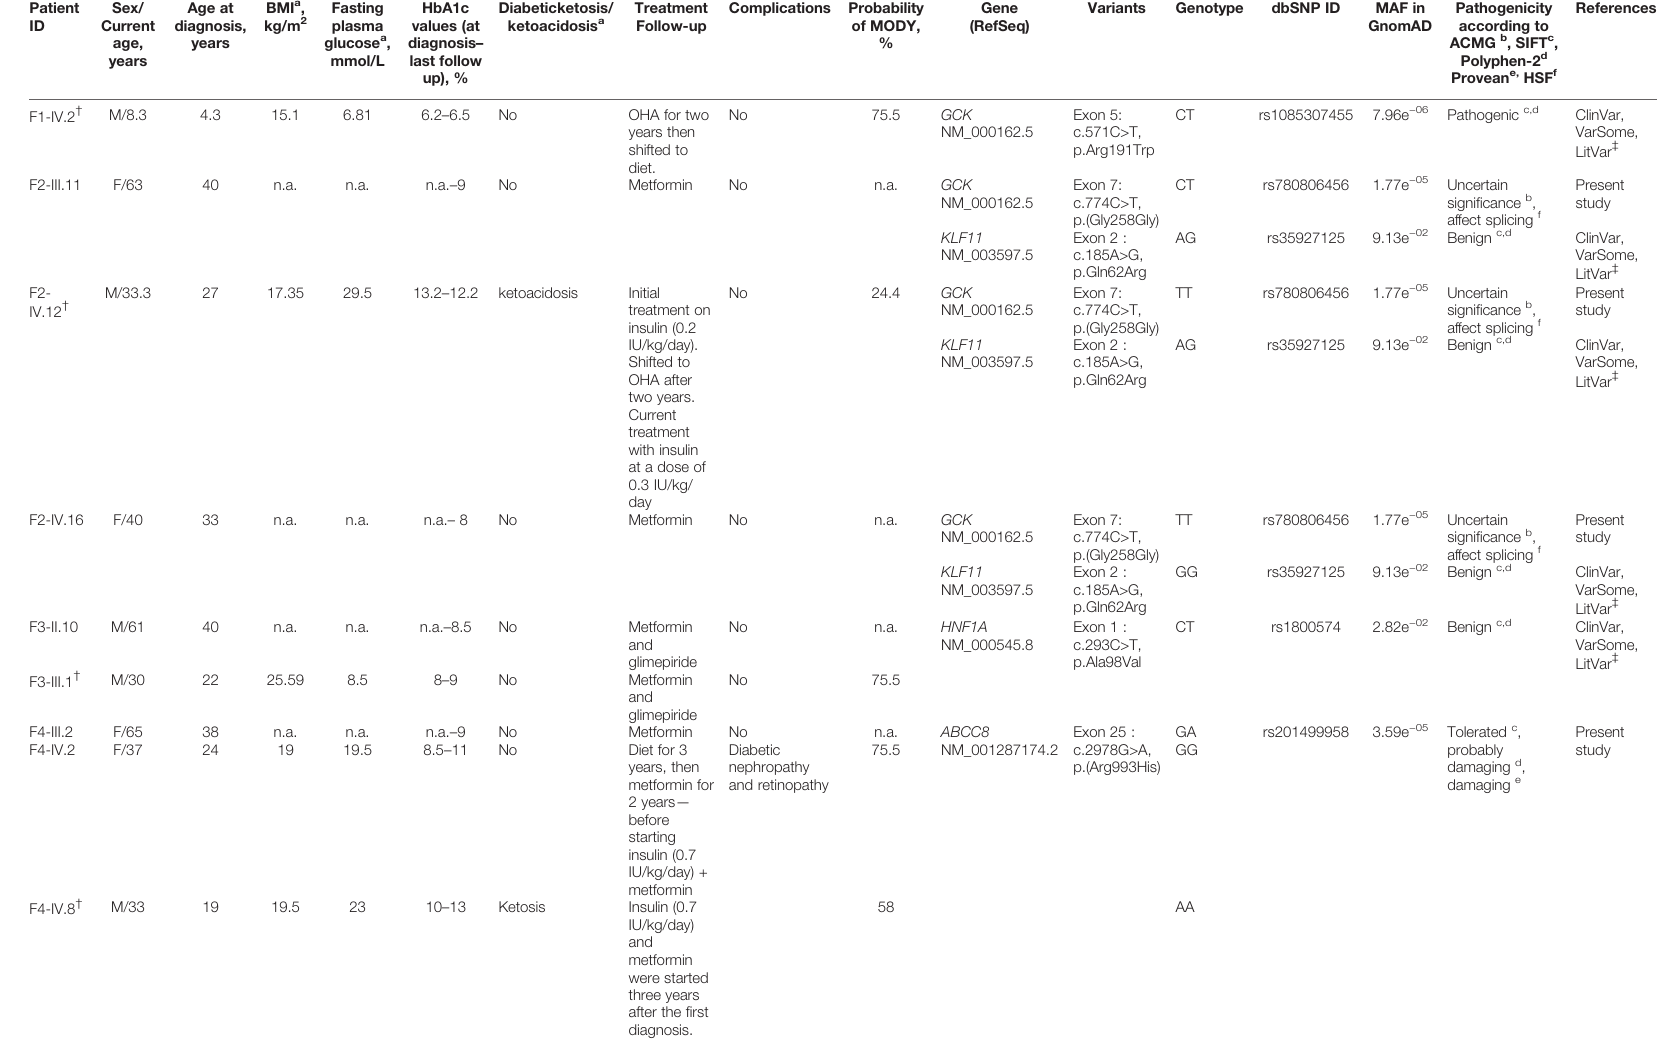
BMI, Body Mass Index; HbA1c, glycated hemoglobin; n.a., Not available; OHA, oral hypoglycemic agents. a BMI and fasting plasma glucose values at fi rst admission with/without the acute metabolic disorder. The probability of MODY was calculatedonlyfortheyoung-onsetdiabetespatientsusingMODYprobabilitycalculator. b,c,d,e,f Thepredictionofthedeleteriouseffectofvariantsusingdifferenttools.TheestimatedminorallelefrequencyforHNF1Ap.A98Vvariantwasaround 3%;whiletheGCKp.(Gly258Gly)variantwasabsentin50healthysubjects.TherestrictionenzymesHaeIIIandHinP1IwereusedtodigestthePCRproductscoveringthers1800574andrs780806456,respectively. † Indexcase. ‡ Variantfound in LitVar